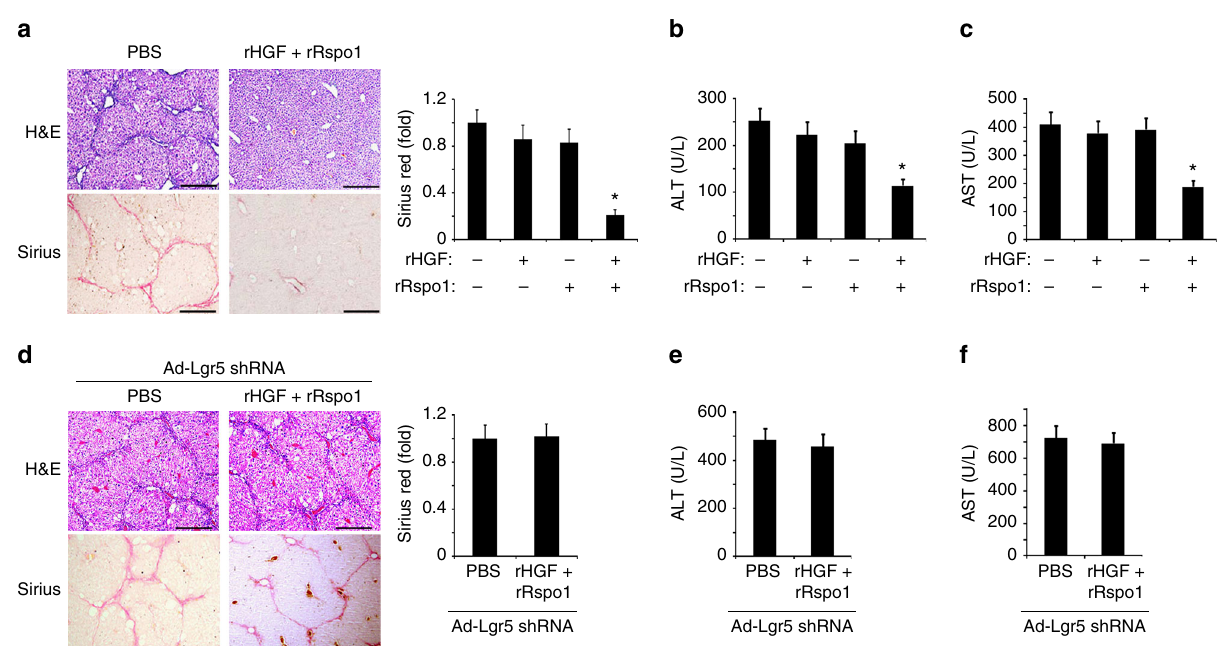
Fig. 4 rHGF/rRspo1 decreased liver fi brosis through the induction of Lgr5 + cells. a – c rHGF/rRspo1 decreased CCL4-induced liver fi brosis and recovered liver functions. CCL4-induced liver fi brosis and rHGF/rRspo1 protein treatments were described in Fig. 3g; the livers were harvested and stained using H&E and Sirius Red for fi brosis analysis ( a ). The serum was harvested for ALT and AST analysis ( b , c ). d – f rHGF/rRspo1 failed to decrease CCL4-induced liver fi brosis and recover the liver functions when Lgr5 was knocked down. CCL4-induced liver fi brosis and Ad-Lgr5 shRNA infections, and rHGF/rRspo1 protein treatments were described in Supplementary Fig. 15a; the livers were harvested and stained using H&E and Sirius Red for fi brosis analysis ( d ). The serum was harvested for ALT and AST analysis ( e , f ). For a , d , scale bars, 200 μ m, the results are shown as mean ± s.d. of fi ve independent sections taken randomly per mice, and a total of 50 tissue specimens in each group ( n = 10 mice), * p < 0.05. For b , c , e , f , triplicates for each condition were analyzed. The results are shown as mean ± s.d. of three independent experiments. * p <